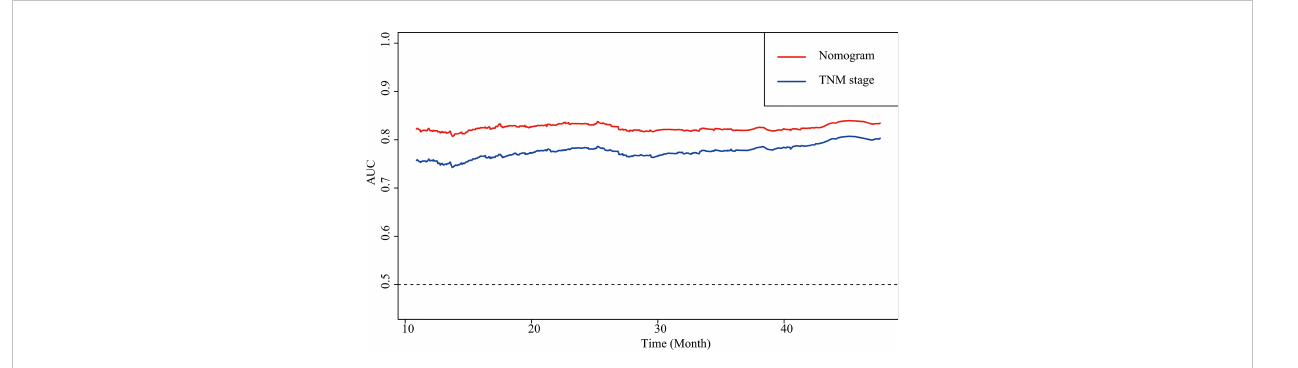
FIGURE 5 AUCs of the nomogram and the TNM stage in patients with CRC. AUC, area under the ROC curve; ROC, receiver operating characteristic; CRC, colorectal